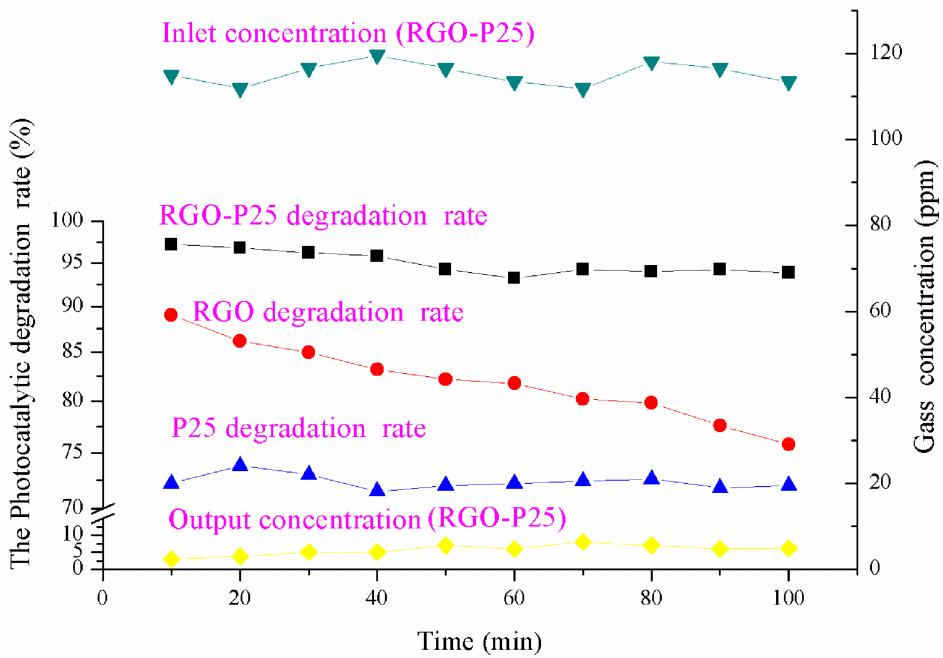
Figure 10. The degradation effect of ammonia by RGO-P25, RGO and